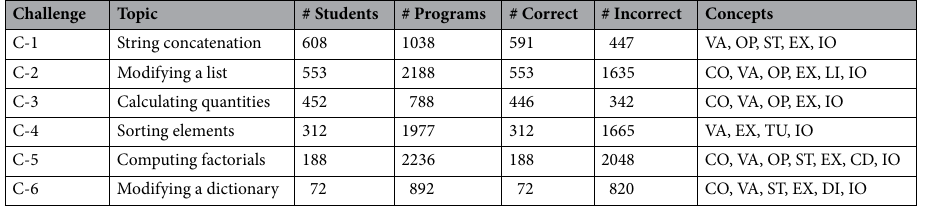
Table 1. Dataset overview.